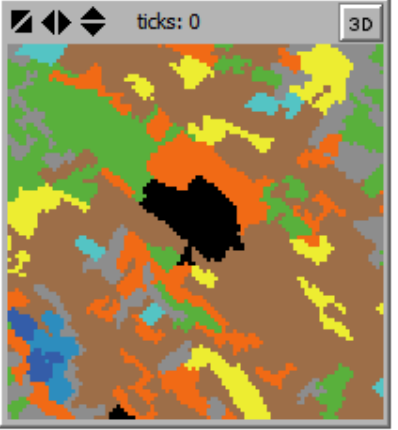
Figure 6. This particular world lies next to the city of Kecskemét and a town called Kerekegyháza can be seen in the middle The ticks in the middle show the current epoch of